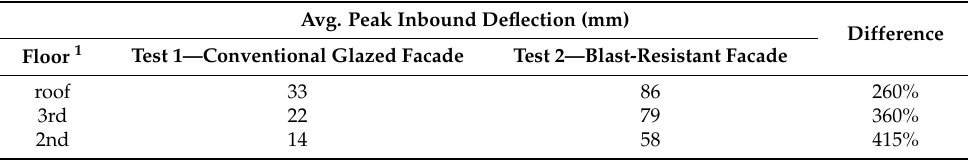
Table 7. Comparison of average of peak inbound lateral deflections for Test 1 and Test 2.